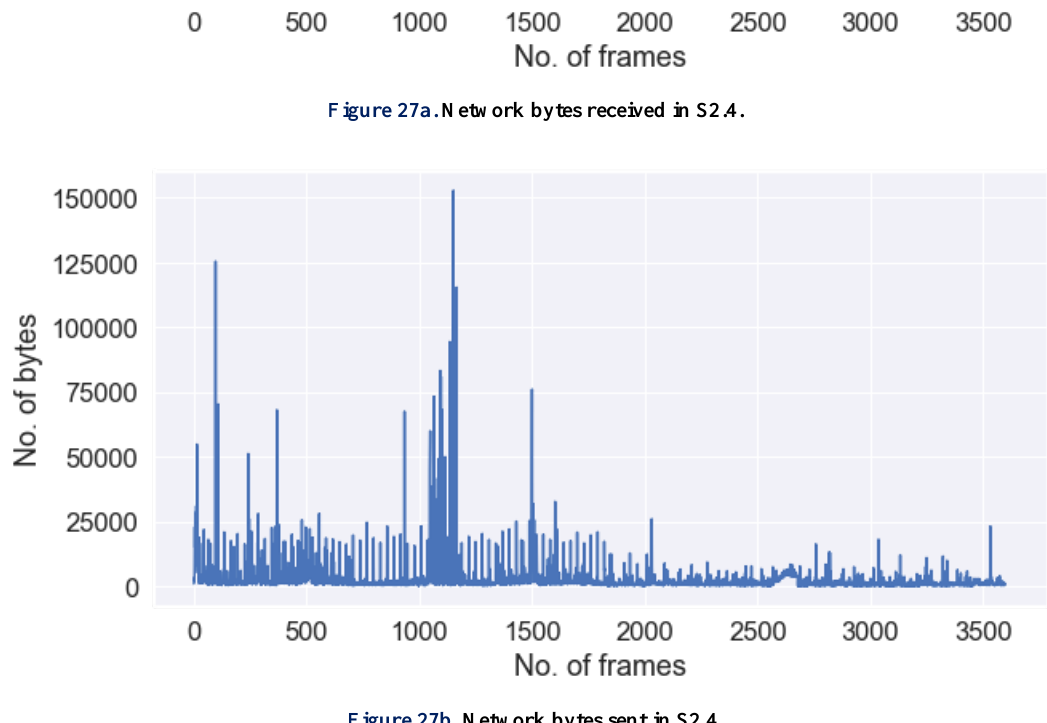
Figure 27b. Network bytes sent in S2.4.